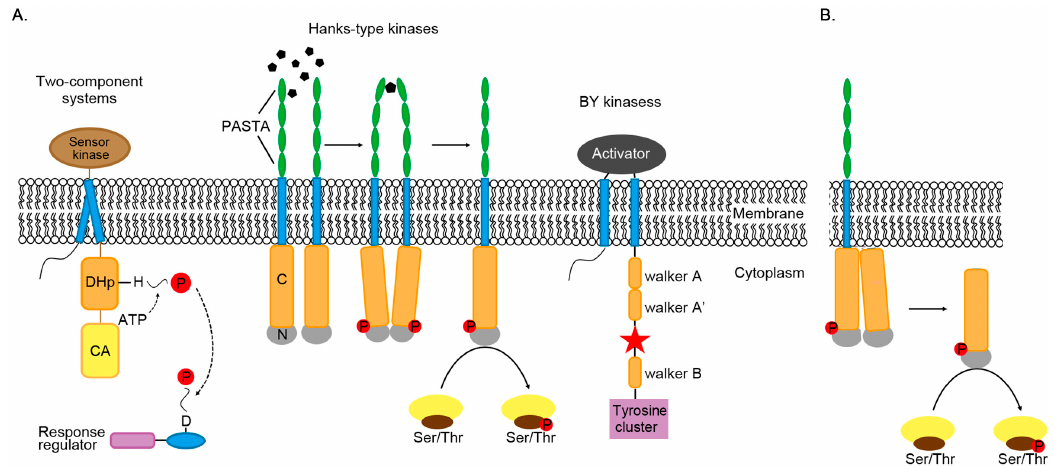
Figure 1. Phosphorylation mechanism of three types of kinases. ( A ) Three types of protein kinases catalyze the transfer of phosphate groups (P) to histidine (H), aspartic acid (D), serine, threonine and tyrosine. Most of these kinases are bound to the membrane. Extracellular domain PASTA (penicillin-binding protein and serine / threonine kinase-associated) binds peptidoglycans and induces the intracellular catalytic domains closer, resulting in activating kinase domains by autophosphorylation. After phosphorylation, two monomers dimerize through the back sides of the N-terminal lobes (N). BY kinase will interact with its activator to stabilize its ATP-binding domain. The red star is the phosphorylation site. DHp is the abbreviation of dimerized histidine phosphate transfer domain, and CA is the abbreviation of catalyzed binding to ATP. ( B ) In STK, activated kinases can directly phosphorylate target proteins.